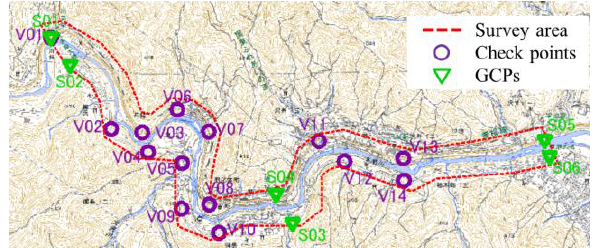
Figure 4. GCPs and check points in the preliminary experiment